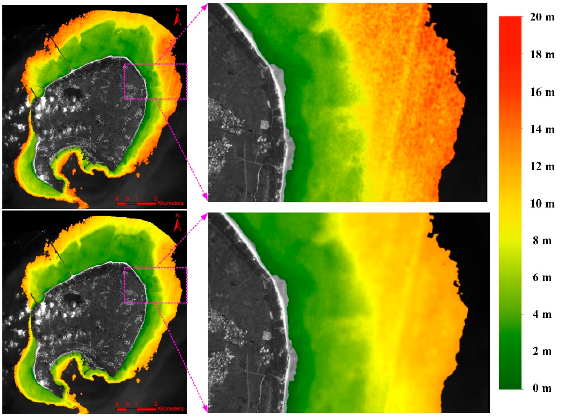
Figure 9. The water depths estimated by the ZY-3 image: ( Top ) before the global adjustment; and ( Bottom ) after the global adjustment.